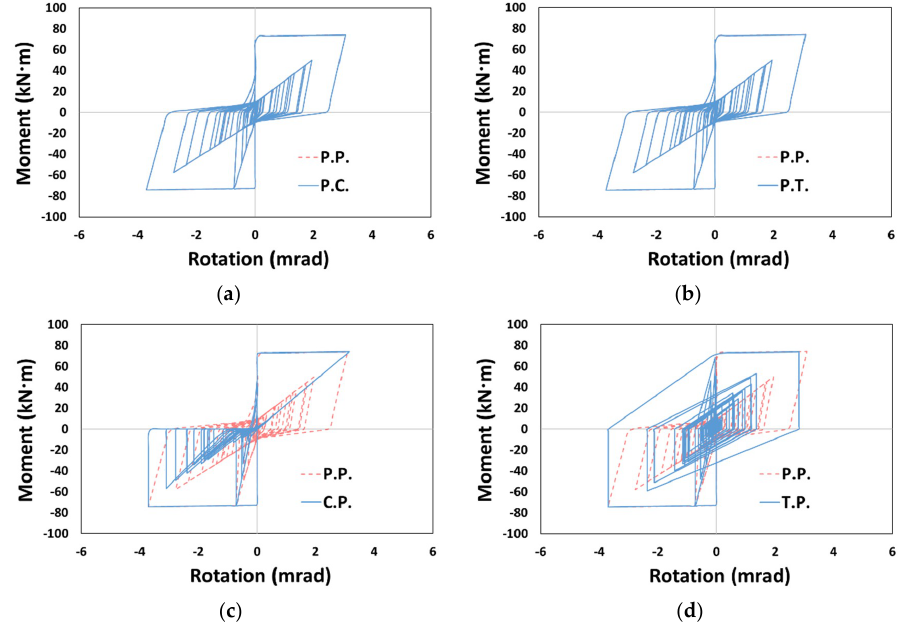
Figure 15. Moment–rotation curve (Type 1, Northridge, Y-dir.): ( a ) P.C, ( b ) P.T., ( c ) C.P., and ( d ) T.P.